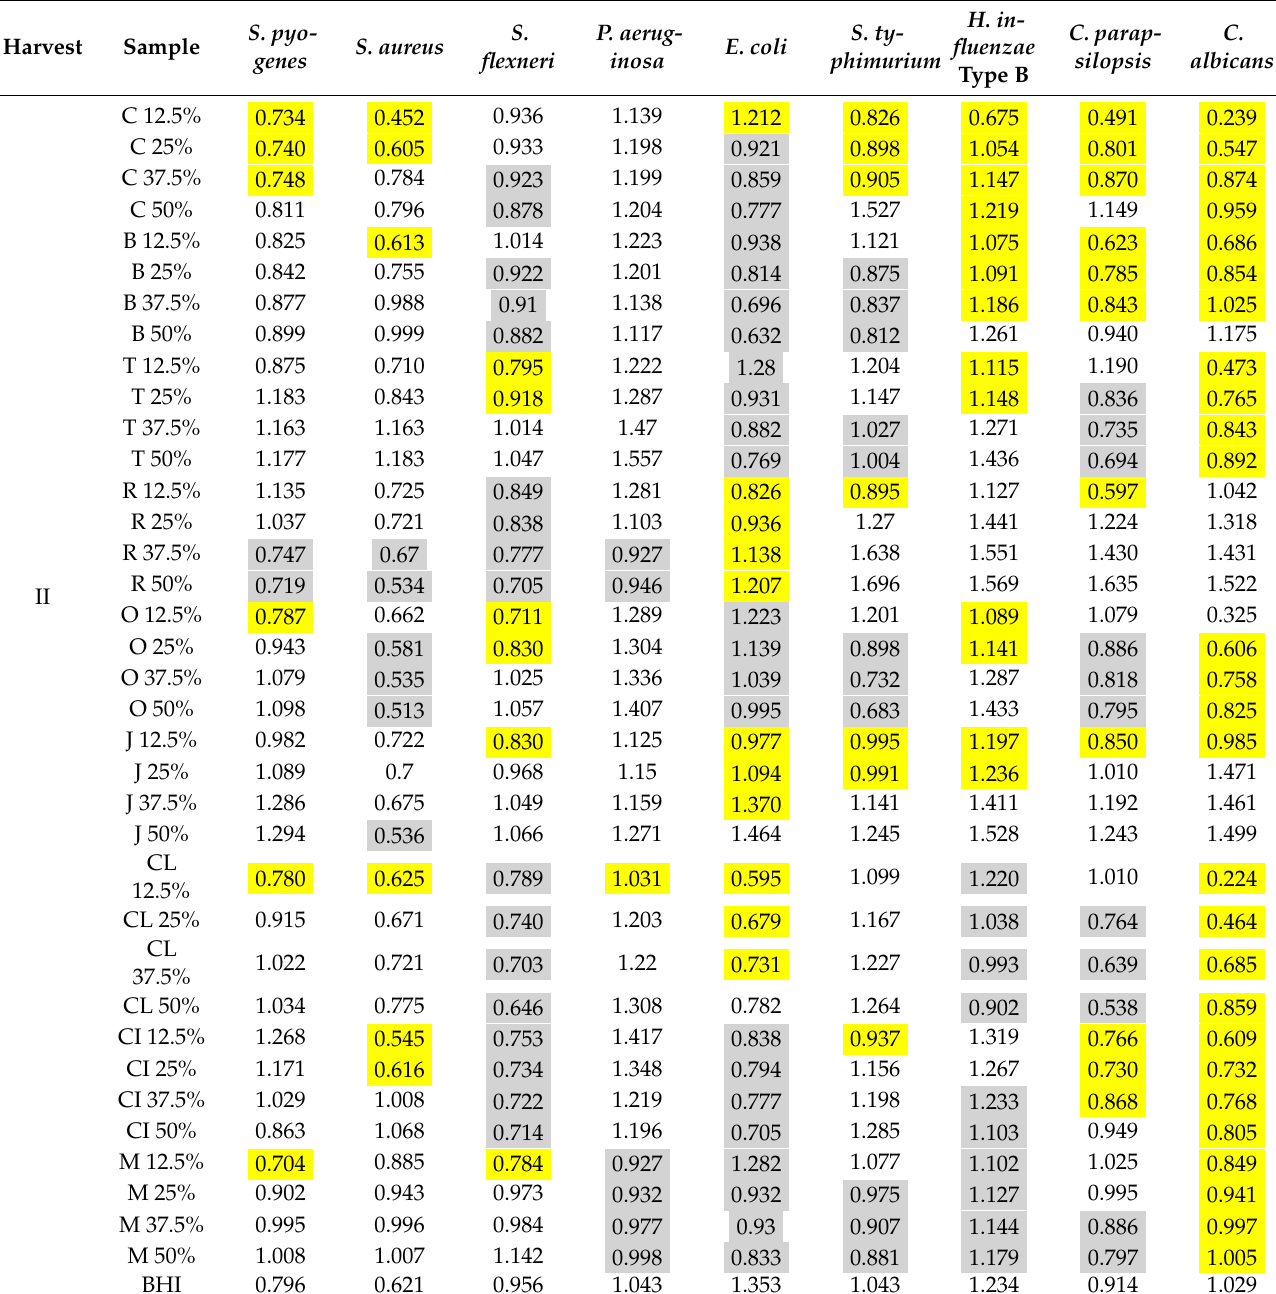
Table 3. OD value (540 nm) for honey samples after treatment with EOs (Harvest II).